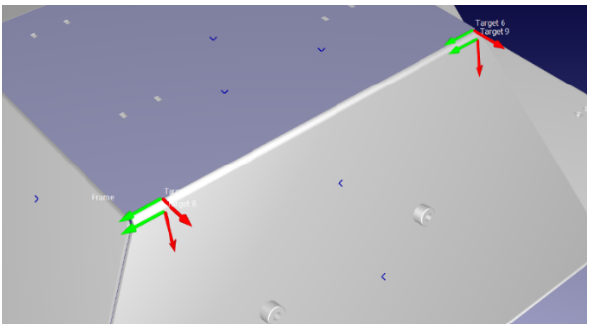
Figure 11: Defining location and orientation of the seam [12]